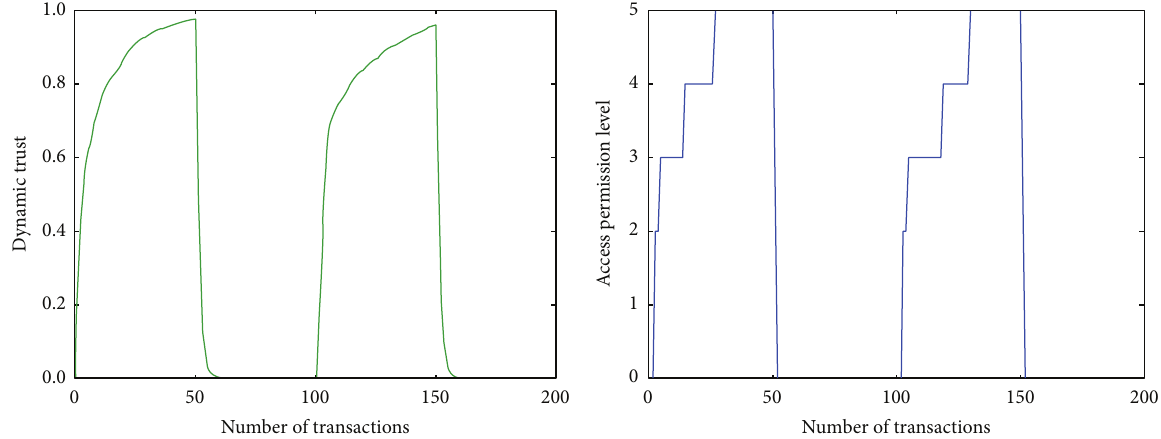
Figure 3: Changing of dynamic trust and access permission level against a strategic user.